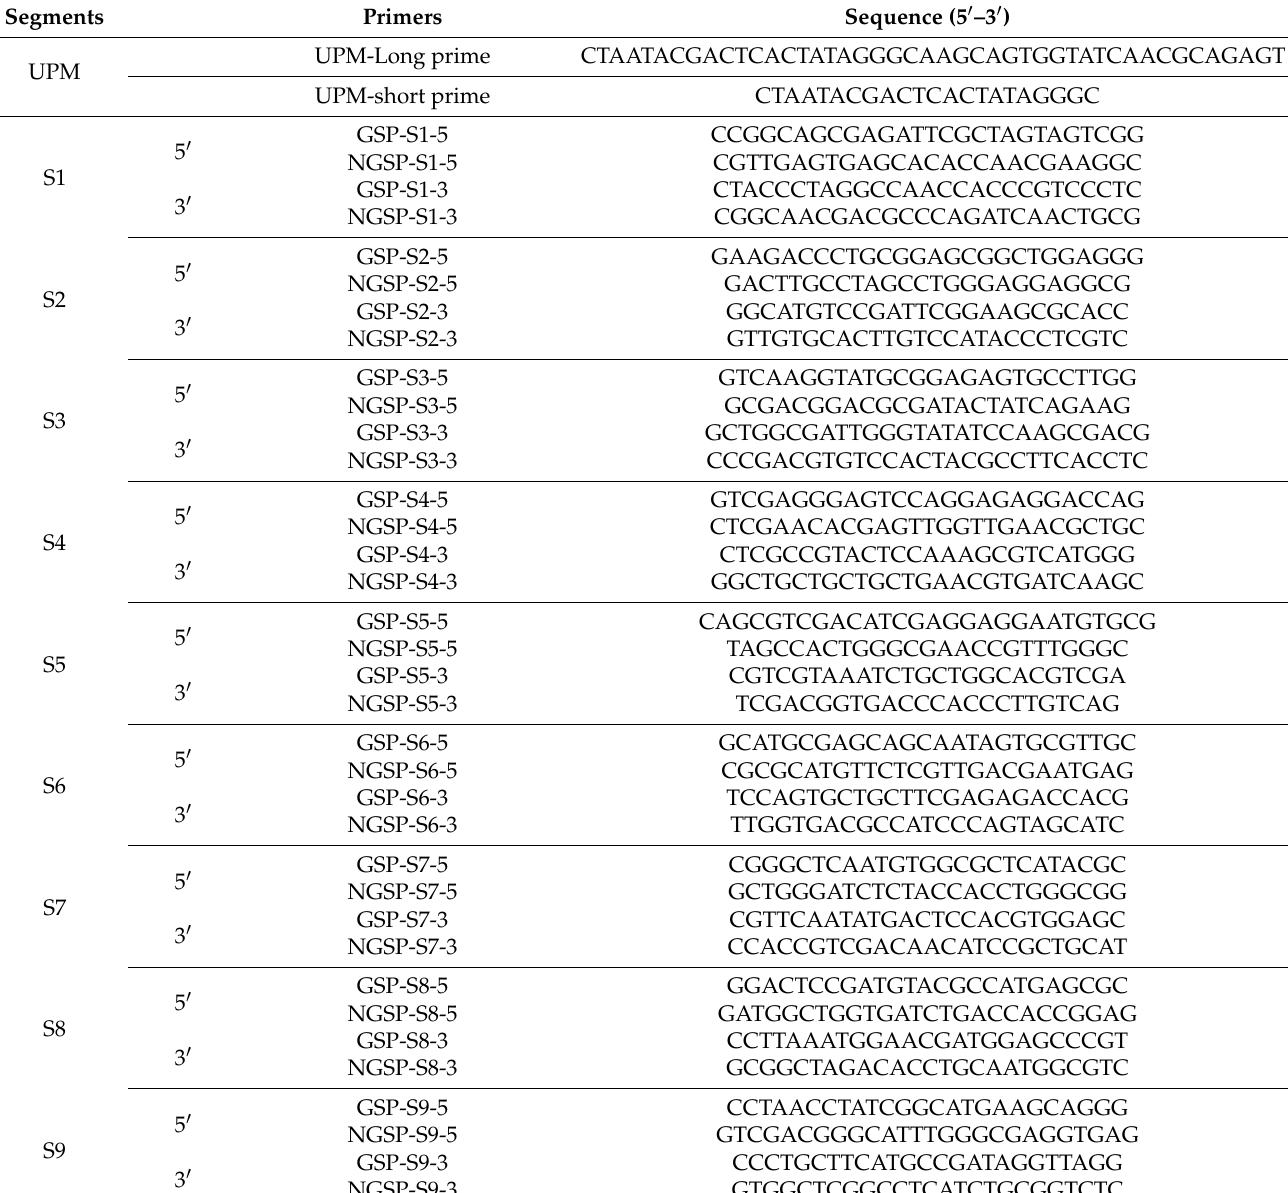
Table 1. Primers used for rapid-amplification of cDNA